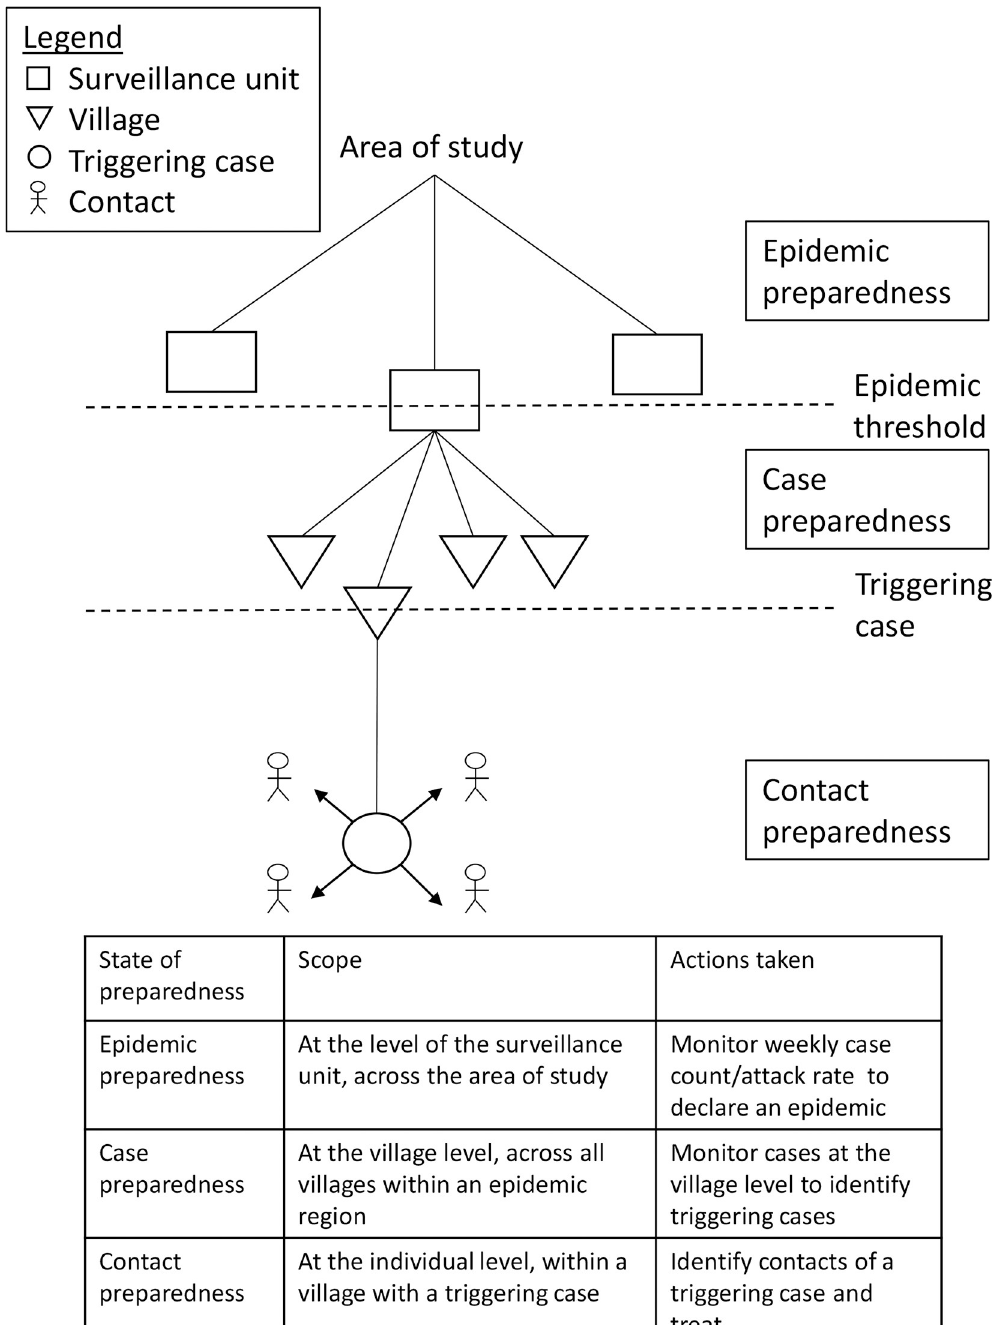
Fig 2. Schematic of the reactive prophylaxis protocol. Description of the reactive prophylaxis protocol, in the pre- epidemic, epidemic, and contact prophylaxis